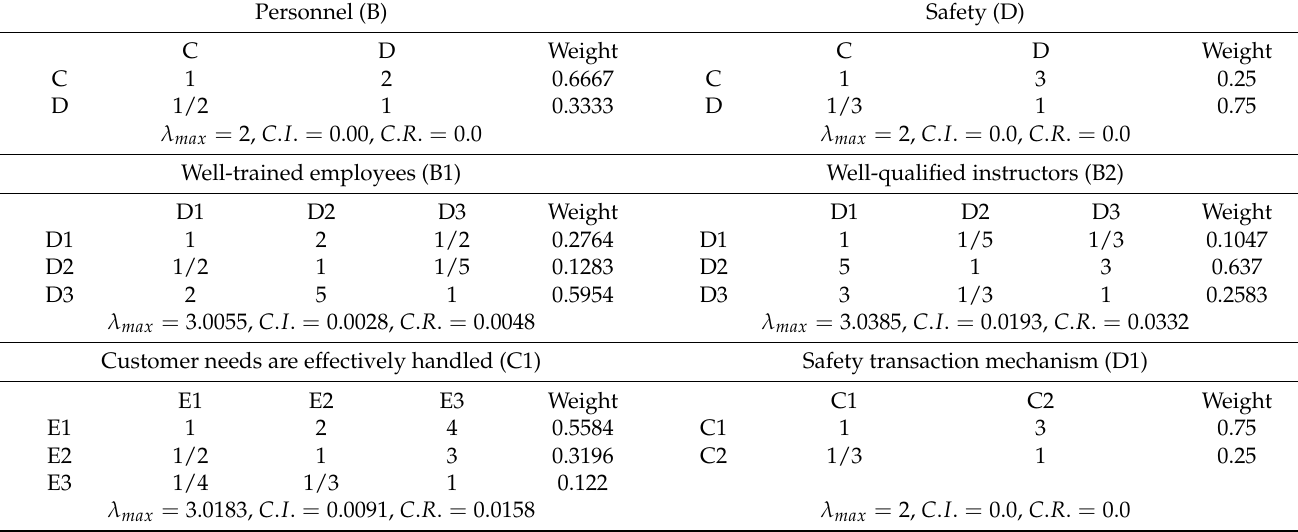
Table 11. The de-fuzzified pairwise comparison matrix for each criterion under specific